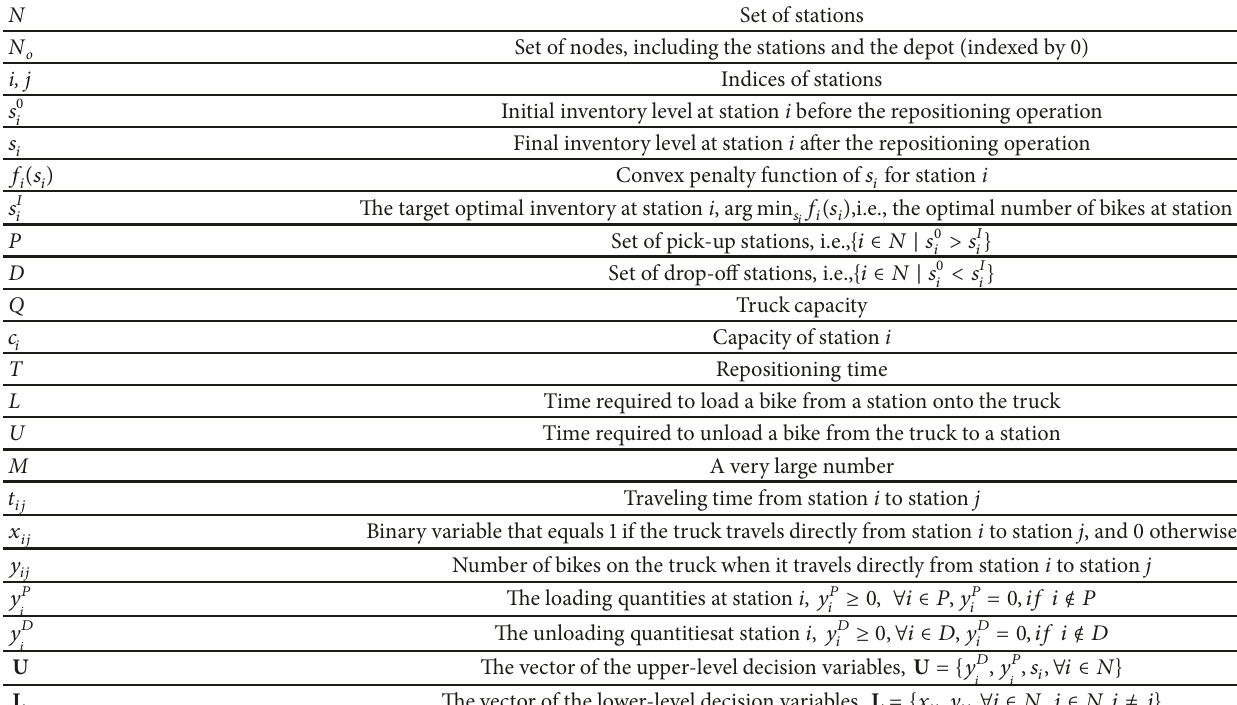
Table 3: Notations for the bi-level